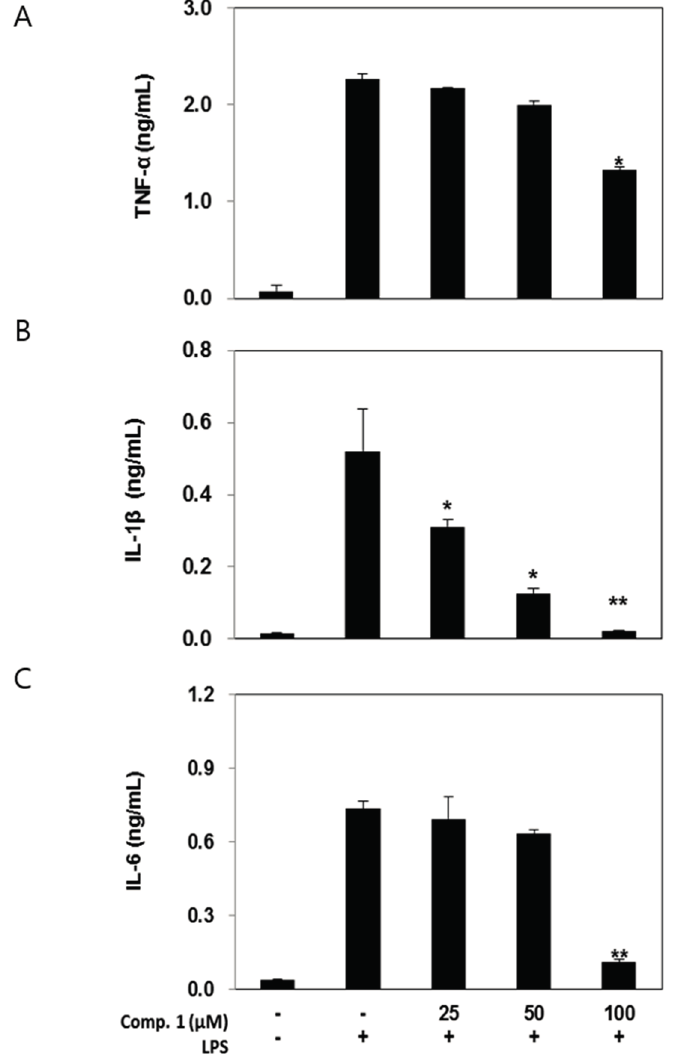
Figure 4. Effect of compound 1 on the production of cytokines stimulated by LPS. Production of TNF- α ( A ), IL-1 β ( B ) and IL-6 ( C ) were measured in the medium of RAW